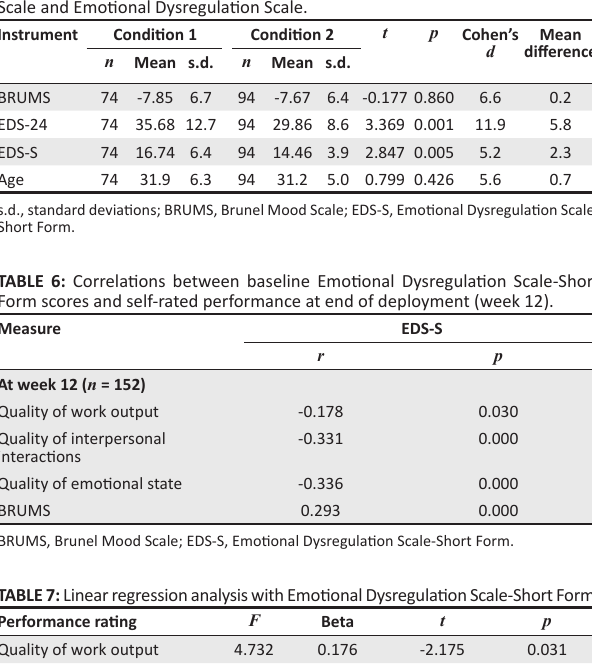
TABLE 7: Linear regression analysis with Emotional Dysregulation Scale-Short Form. Performance rating